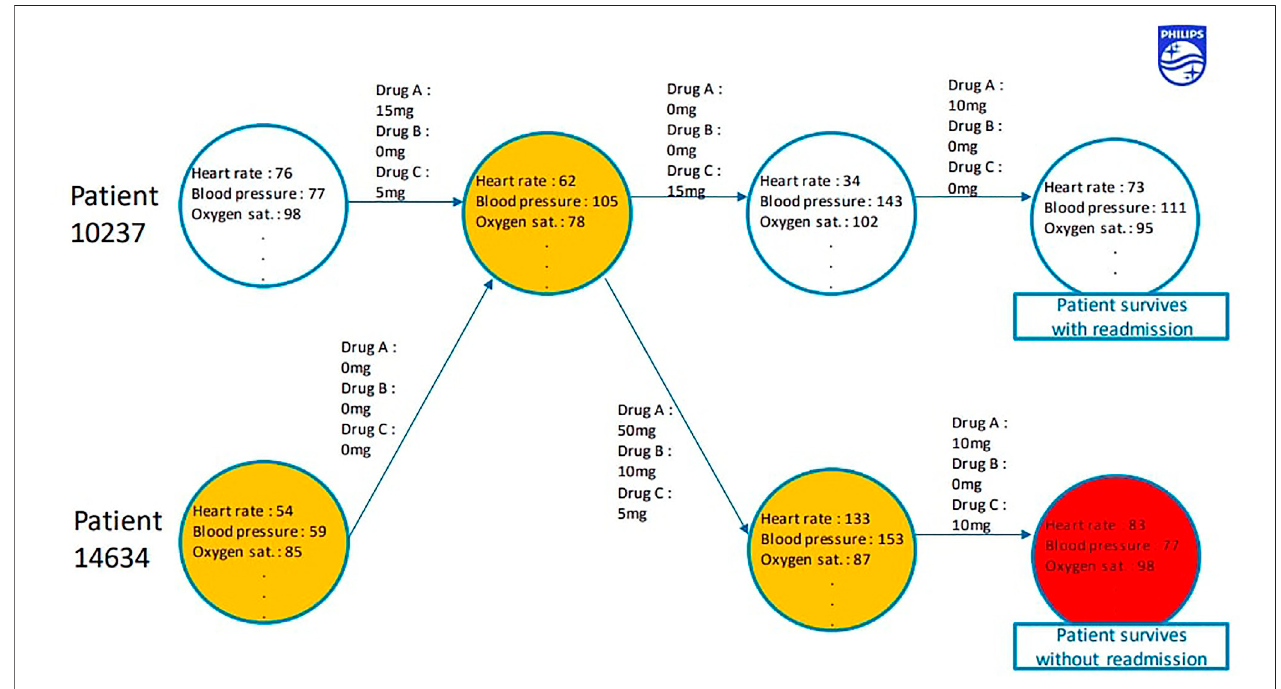
FIGURE 8 | GraphSim.